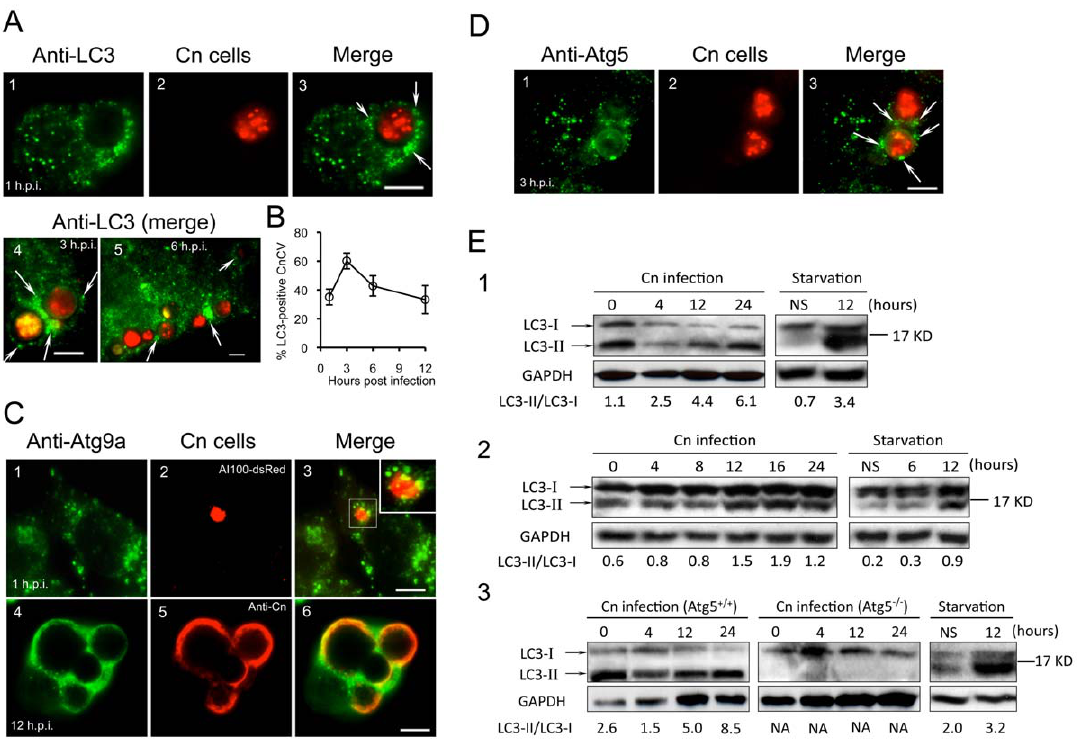
Figure 8. Cryptococcusneoformans interactions with Atg proteins during infection. Murine J774.A1 or RAW264.7 cells were seeded on 12- mm coverslips placed on the bottom of 24-well plates and then infected with Cn (AI100-dsRed) for 1 or 3 hr. At 3 h.p.i., the infected cells were wash three times and then continuously incubated in fresh medium supplemented with 20 m g/ml fluconazole. At the indicated time points, the infected cells were fixed and prepared for immunofluorescence microscopy using antibodies directed against mouse proteins LC3 ( A , J774.A1 cells) or Atg9a ( C , RAW264.7 cells. Inset in C3 : a magnified section shows Atg9a in close apposition to CnCvs during an early stage of infection) and Atg5 ( D , J774.A1 cells). Regions of colocalization appear yellow in the images ( C3 and C6 ). CnCVs surrounded by host proteins are indicated by white arrows. Scale bars indicate 5 m M. Images were taken from a representative experiment of at least three independent experiments. B . Quantification of Cn cells that resided in host LC3-positive compartments during a time course of infection. At each time point, the percent of total cells analyzed in which LC3 was tightly associated with CnCvs was calculated and plotted as a function of time. Data represent the means 6 SD from at least three independent experiments. For each experiment, at least 300 internalized or replicative Cn cells were analyzed. E . Induction of LC3-I to LC3-II processing by Cn infection. Murine J774.A1 ( E1 ), RAW264.7 ( E2 ) macrophages or MEFs ( E3 ) were infected with Cn strain AI100-dsRed or cultured in serum free DMEM (starvation) for 12 hr. At the indicated time points, Cn infected and serum starved cell samples were collected, and subjected to immunoblotting analysis using antibodies directed against mouse LC3. NS=non-starved. Representative images were taken from a single experiment. Three independent experiments gave similar results.